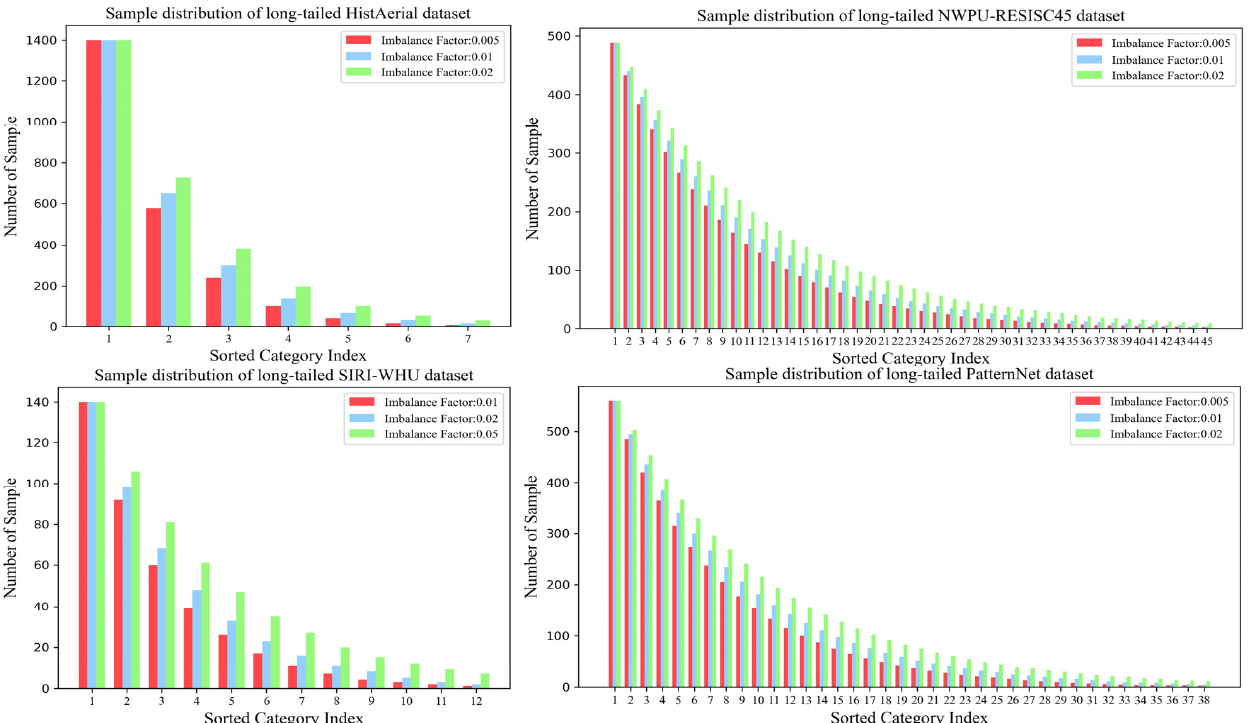
Figure 4. The distribution of the number of samples from each category after long ‐ tailed processing for the HistAerial dataset, the SIRI ‐ WHU dataset, the NWPU ‐ RESISC45 dataset, and the PatternNet dataset.